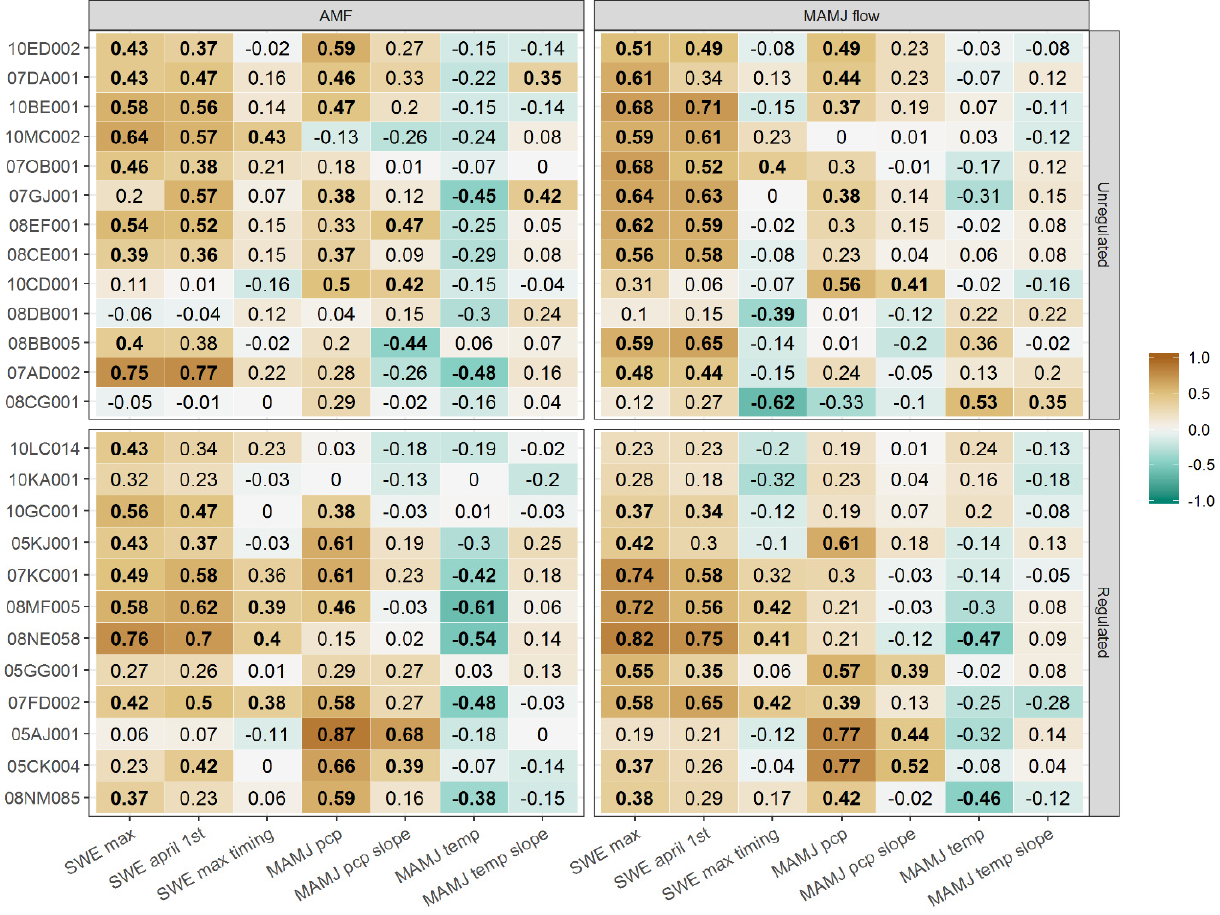
Figure 2. Spearman correlation of AMF ( left panel ) and MAMJflow ( right panel ) with area-averaged predictors corre- sponding to each of the 25 hydrometric stations. Top panels represent stations not affected by regulation while the bottom panels represent regulated basins. Bold entries correspond to Spearman correlations with p < 0.05.